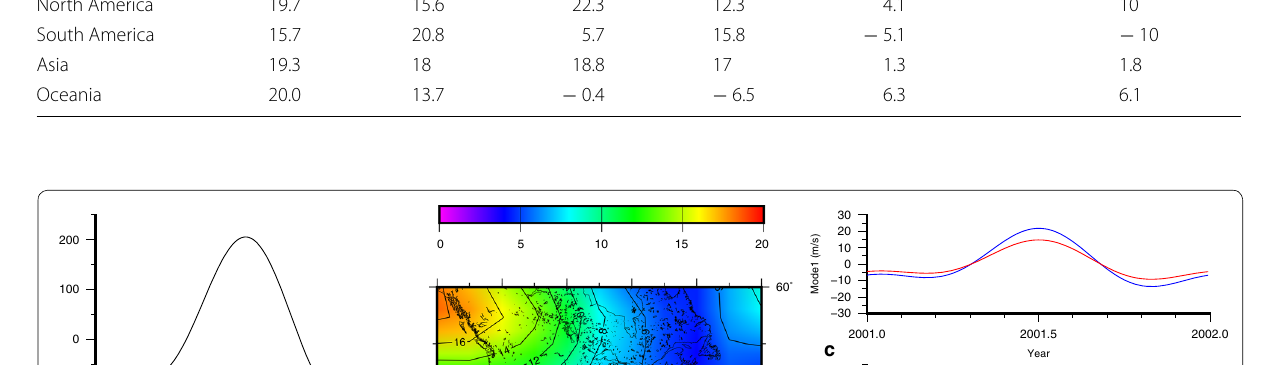
Table 3 Mean values of vTEC lighted sectors in the four regions